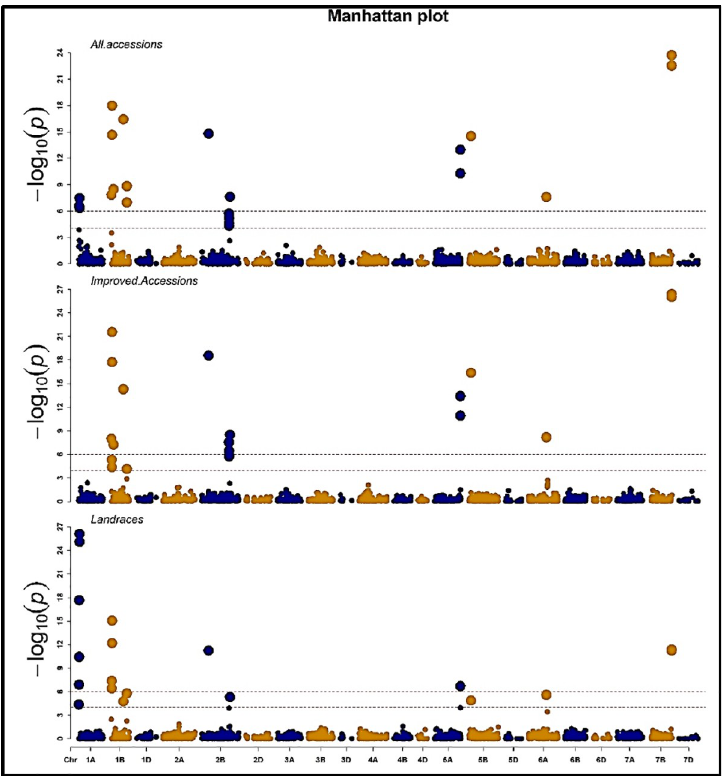
Fig 6. Manhattan plot for stripe rust results obtained from genome-wide association mapping for all accessions (A), improved accessions (B) and landraces (C).